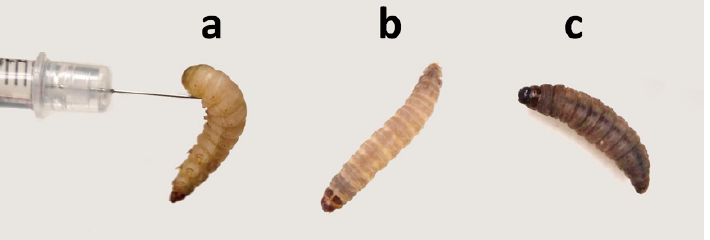
Figure 1. In vivo assays using the Galleria mellonella larva model. Inoculation by injection of different bacteria inoculum ( a ), healthy larva ( b ), and dead larva ( c ) as a result of Klebsiella pneumoniae infection.